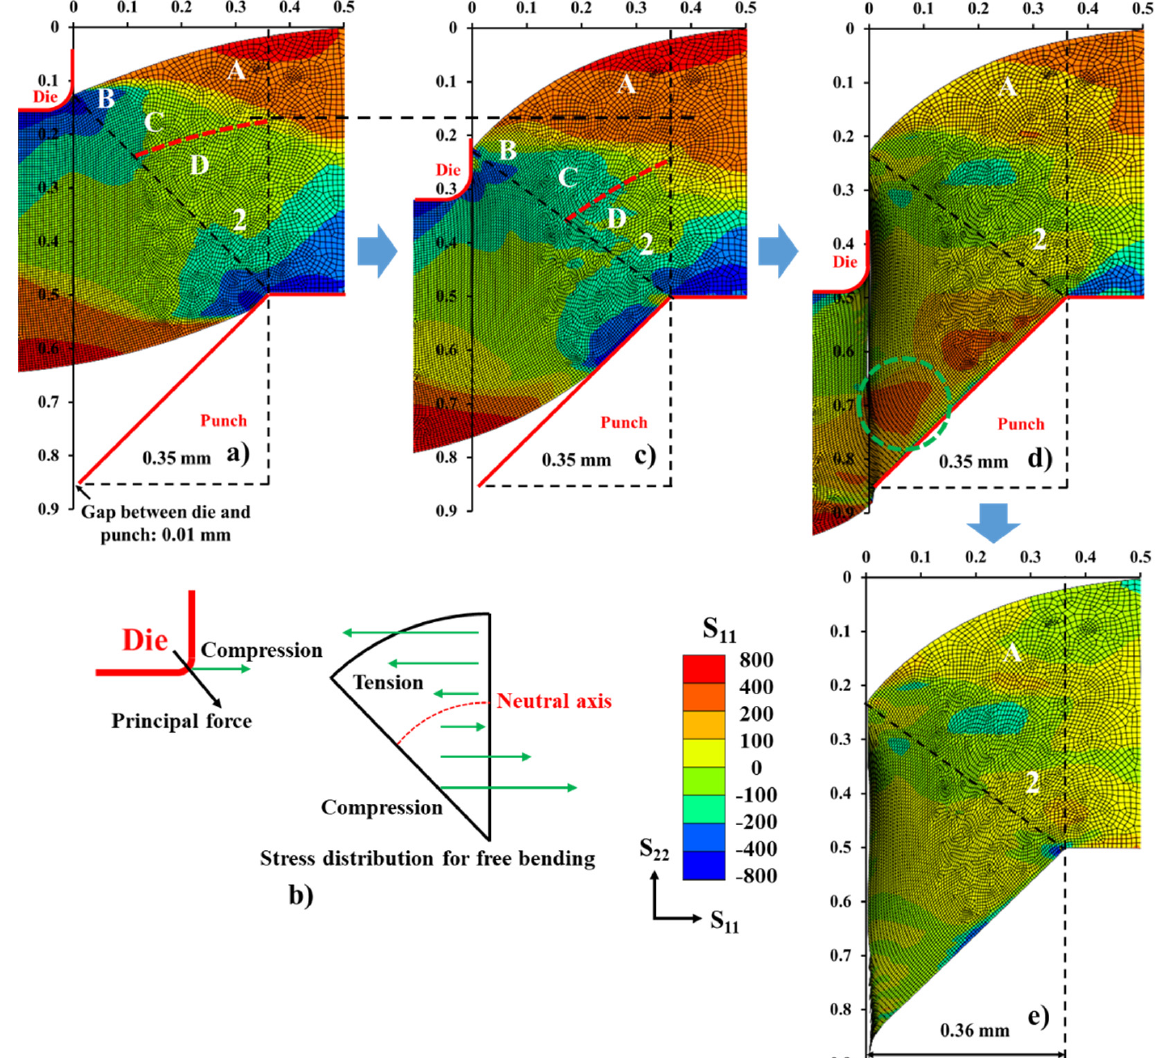
Figure 10. ( a ) Simulated distribution of residual stress in S 11 direction at the beginning of punching. ( b ) Diagram of stress distribution for free bent area and the position near the contact between die and material. Simulated distribution of residual stress in S 11 direction ( c ) during punching, ( d ) after fracture initiation and ( e ) after complete fracture and removal of mold. Number 2 indicates bent area 2. The letters A, B, C and D were used to distinguish the regions in area 2 with different states of residual stress. The dotted lines in ( a , b ) are used to distinguish the depth region A with tensile stress; the green dotted circle in ( d ) corresponds to the area with high tensile stress.